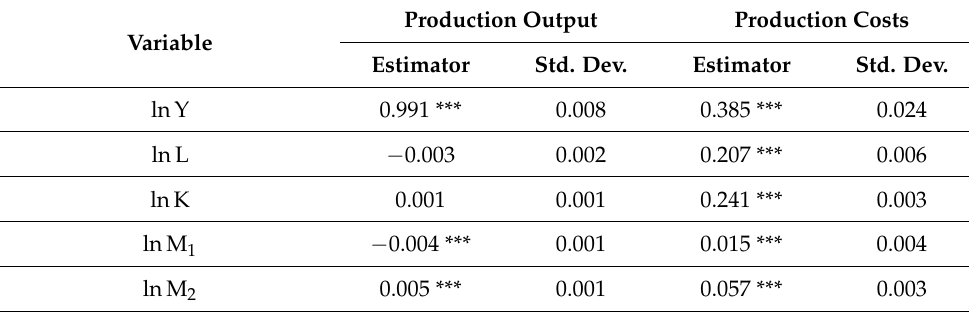
Table 6. Results of agricultural output and costs